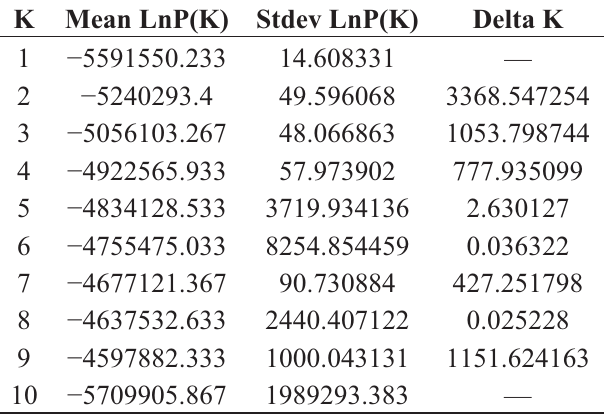
Table 2. Average logarithm of the probability of data likelihoods ( LnP ( D )), their standard deviations, and Delta K for simulations of different K -values of the 520 B. napus accessions.